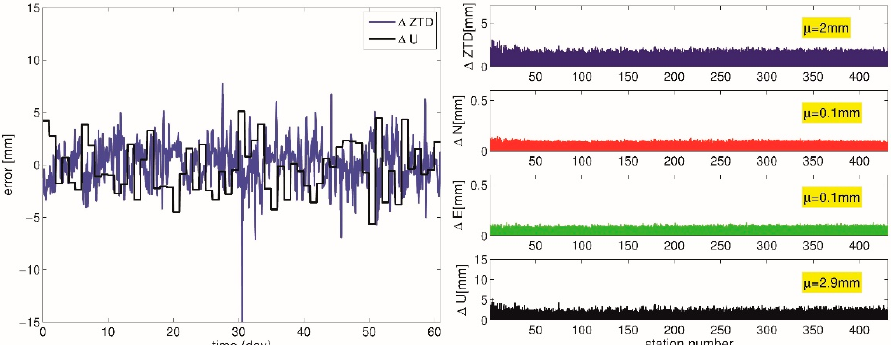
Figure 4. Results for the third simulation experiment. Left panel : the error in the ZTD and the error in the station up-component for the POTS station as a function of time. Right panel : the station- specific RMSE for the ZTD (top), the gradient components (middle), and the station up-component (bottom). The number with yellow background corresponds to the averaged RMSE of the respective